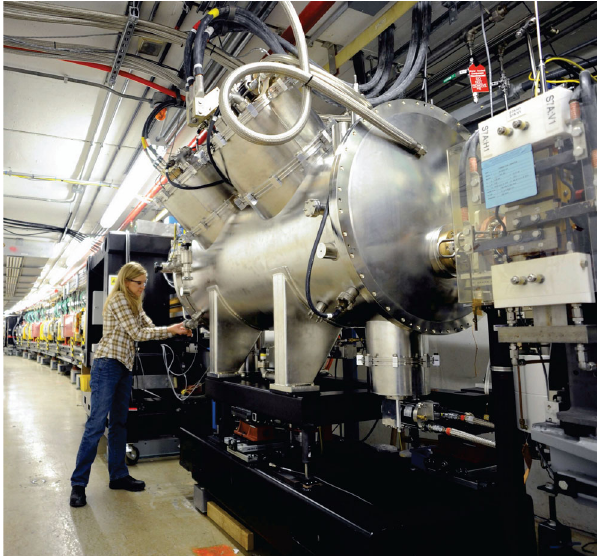
FIG. 1. Superconducting undulator SCU1 in the APS storage ring.